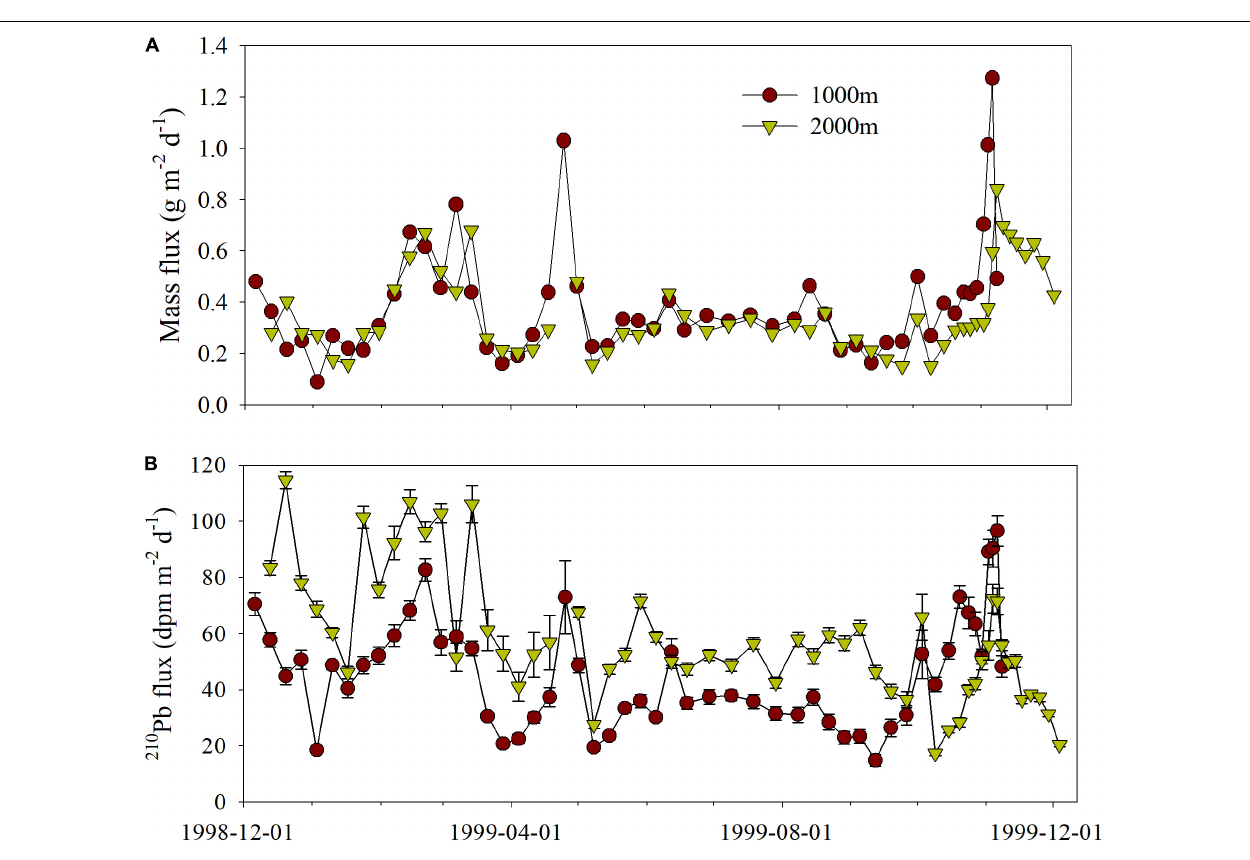
represents the actual atmospheric flux over the annual to decadal time scales. The atmospheric 210 Pb flux in the East Sea is 2– 4 times higher than that in the major open oceans, such